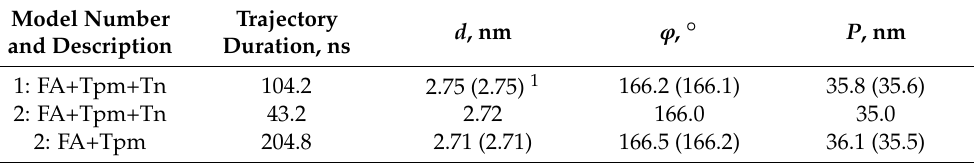
Table 1. Parameters of the F-actin (FA) helix estimated from the MD simulation.